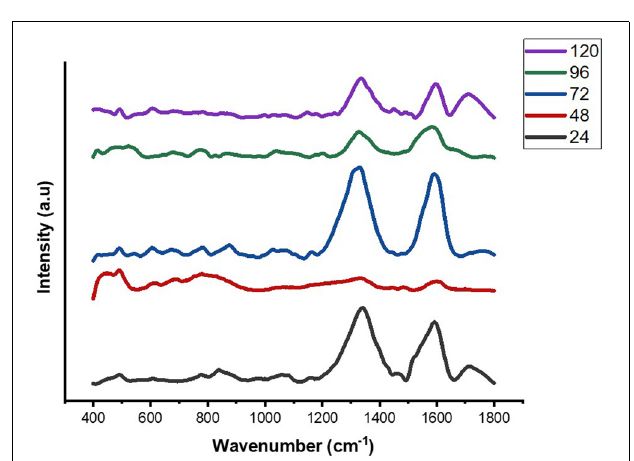
FIGURE 4 | Average SERS spectra of E. cloacae SBP-8 biofilms post-cultivation from 24 to 120 h, where ( n = 5).